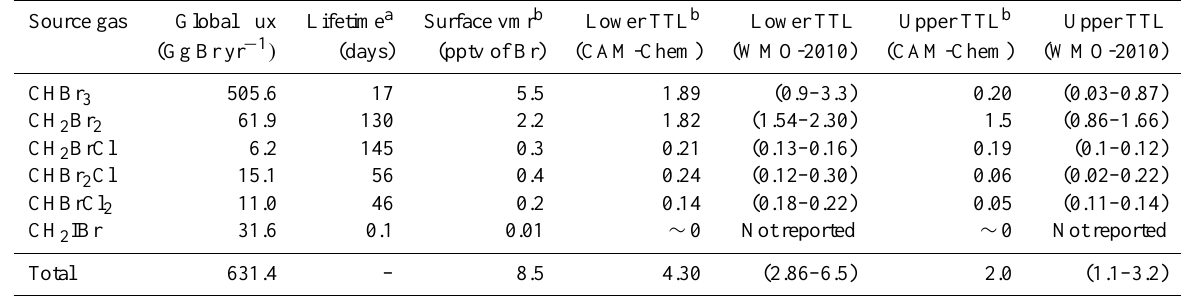
Adapted from Table 3 in Ordoñez et al. (2012) and Tables 1–7 from WMO-2010 (Montzka et al., 2011). The vmr for each species has been multiplied by their respective atomicity in order to represent the contribution to Br y . a Lifetime for each species has been computed considering tropospheric loss by photolysis and reaction with OH. b Values are in pptv of Br, and have been averaged for the tropical latitudinal band (20 ◦ N–20 ◦